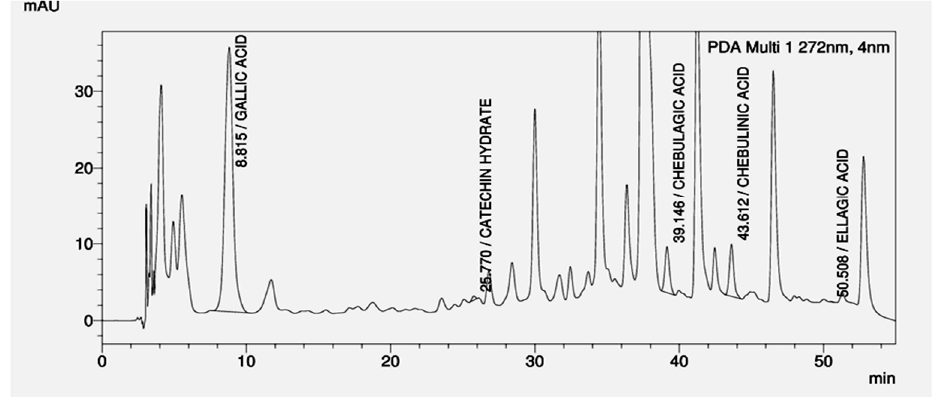
Figure 1. High Performance Liquid Chromatography (HPLC) profile of four plants-based gel formulation. The four plants gel formulation was resolved by reverse phase HPLC using RP 18 column as described in Materials and Methods . The X-axis represents the time (min) and Y-axis represents the voltage (mAU) at 272 nm. The peaks corresponding to gallic acid, catechin hydrate, chebulagic acid, chebulinic acid, and ellagic acid were identified by running standards.